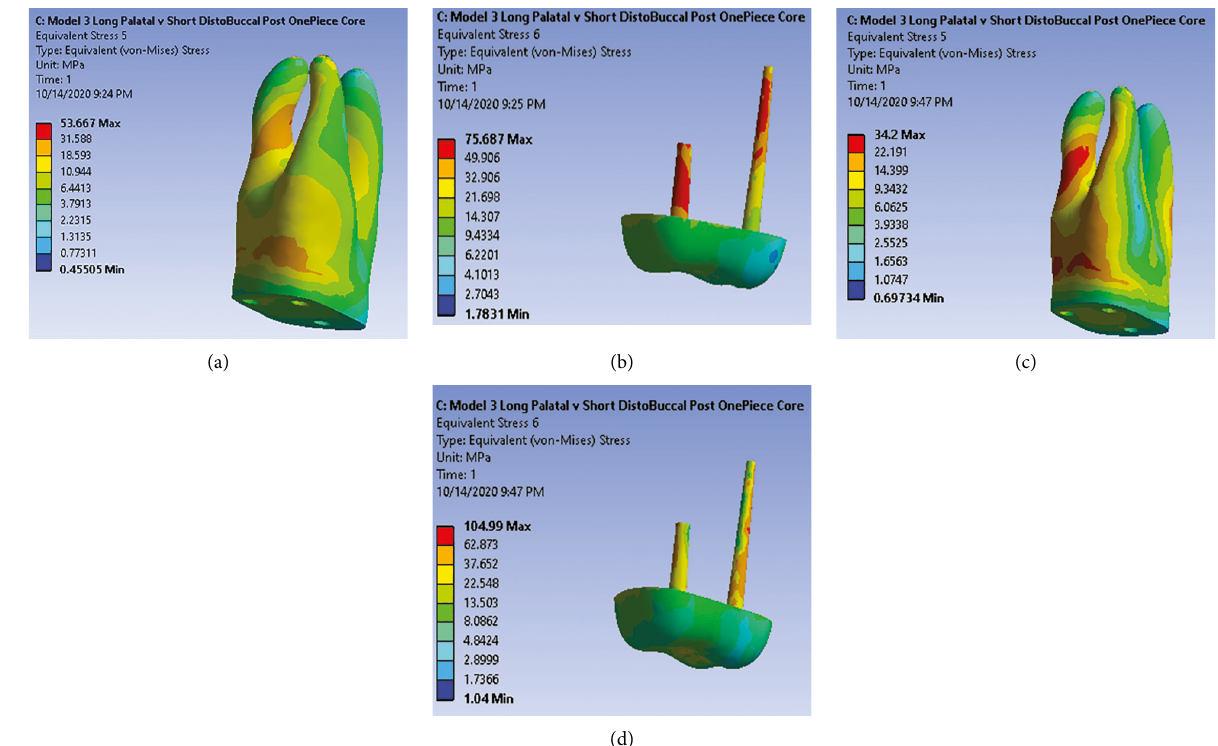
Figure 4: (a) Stress distribution pattern in dentin under 480 (N) along model 3. (b) Stress distribution pattern in post-core under 480 (N) along model 3. (c) Stress distribution pattern in dentin under 240 (N) along model 3. (d) Stress distribution pattern in post-core under 240 (N) along model 3.